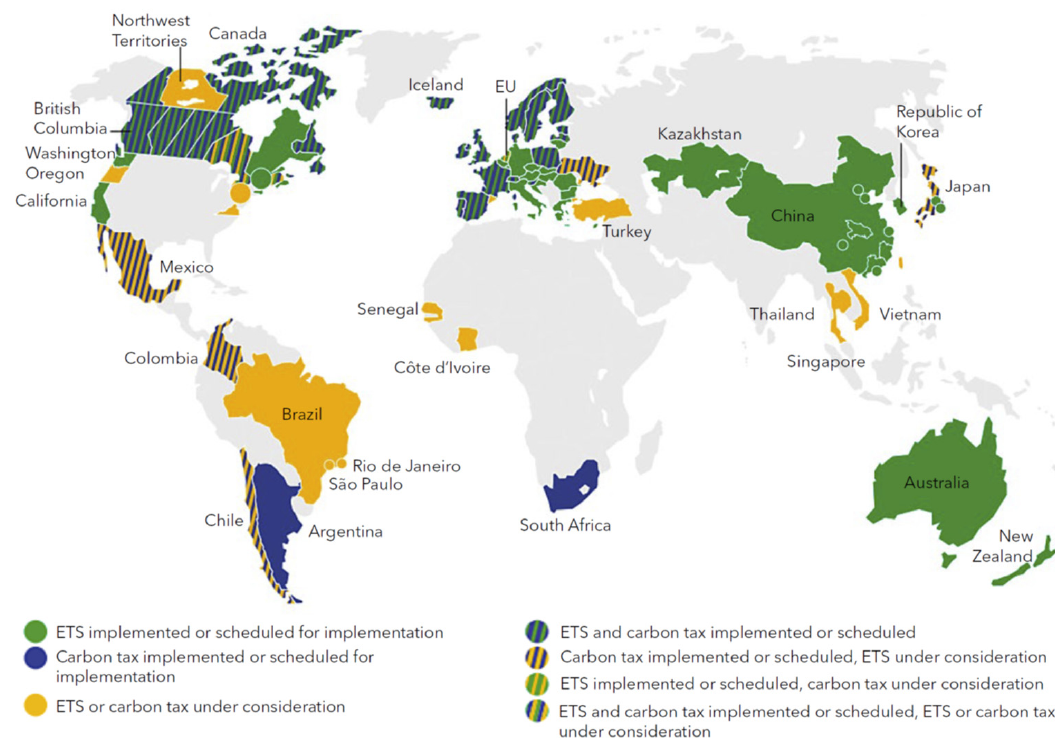
Figure 1. Overview of regional, national, and subnational carbon pricing initiatives. Source: World Bank [2].